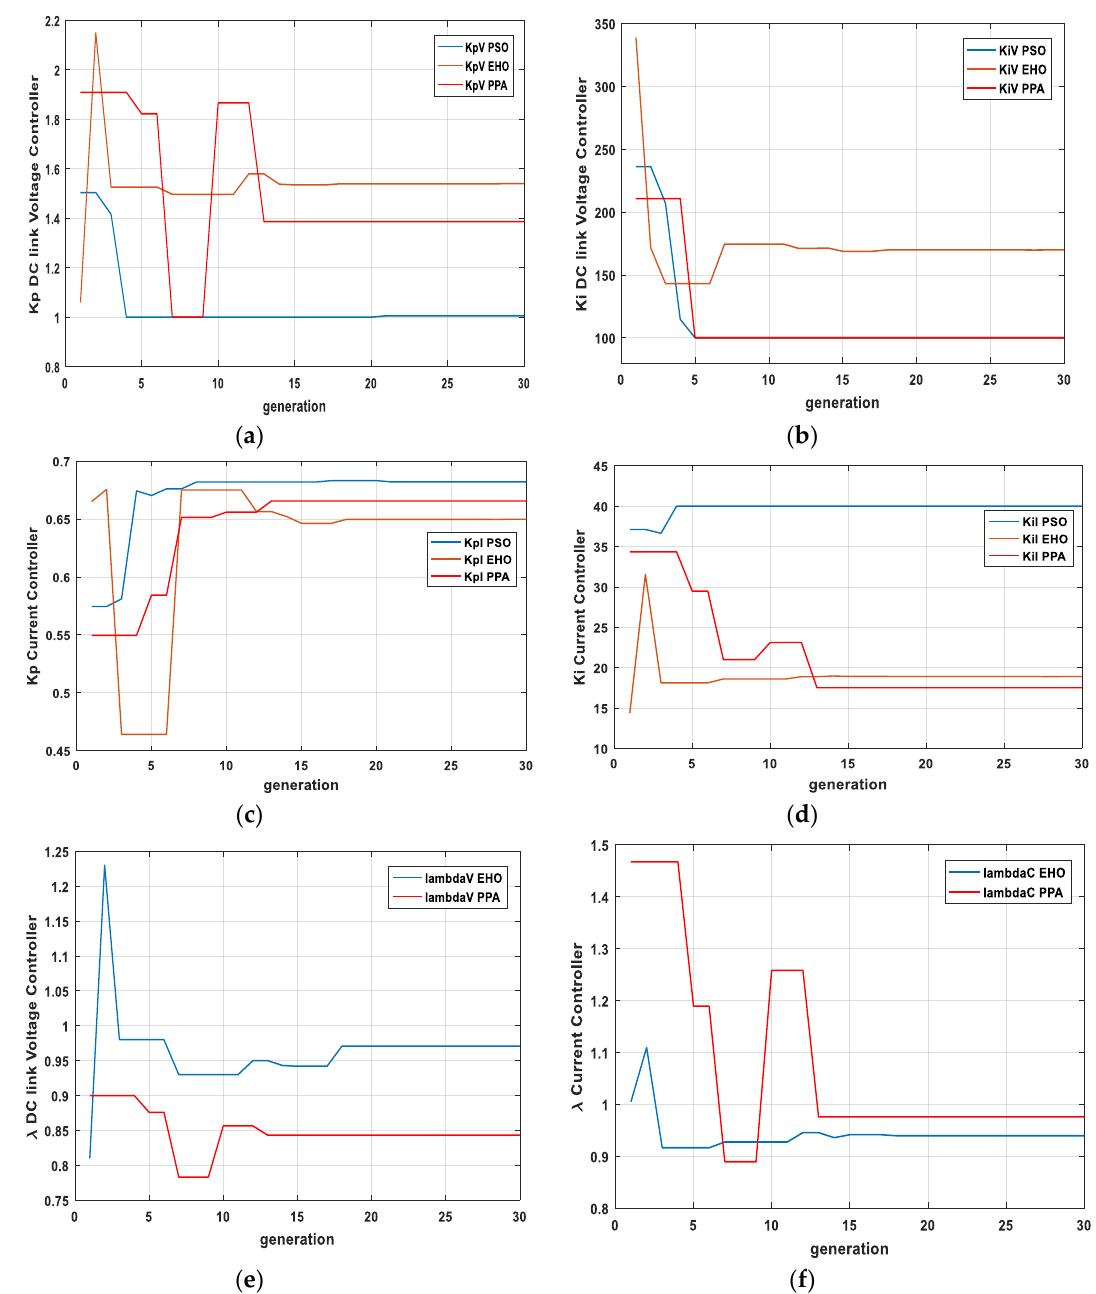
Figure 10. Gain parameters’ trajectory with respect to generation: ( a ) Kp gain of DC link voltage controller; ( b ) Ki gain of DC link voltage controller; ( c ) Kp gain of d- and q-axis current controller; ( d ) Ki gain of d- and q-axis current controller; ( e ) λ of DC link voltage controller; ( f ) λ of current controller.